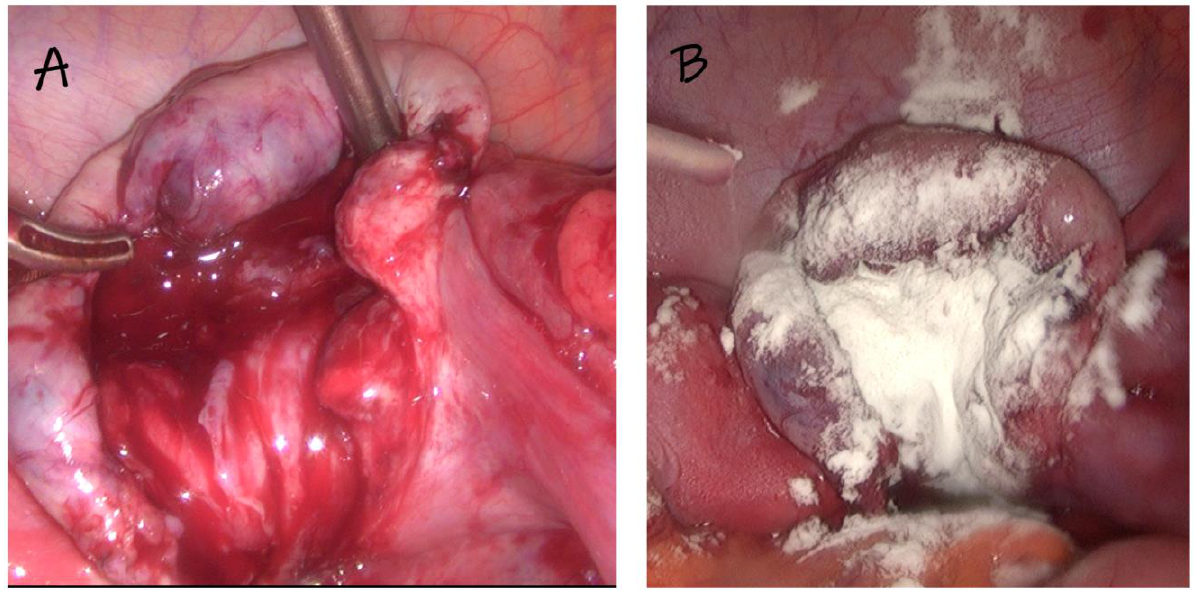
Figure 1. An example of the use of starch on the ovarian tumor bed. ( A) before use, ( B ) after application.